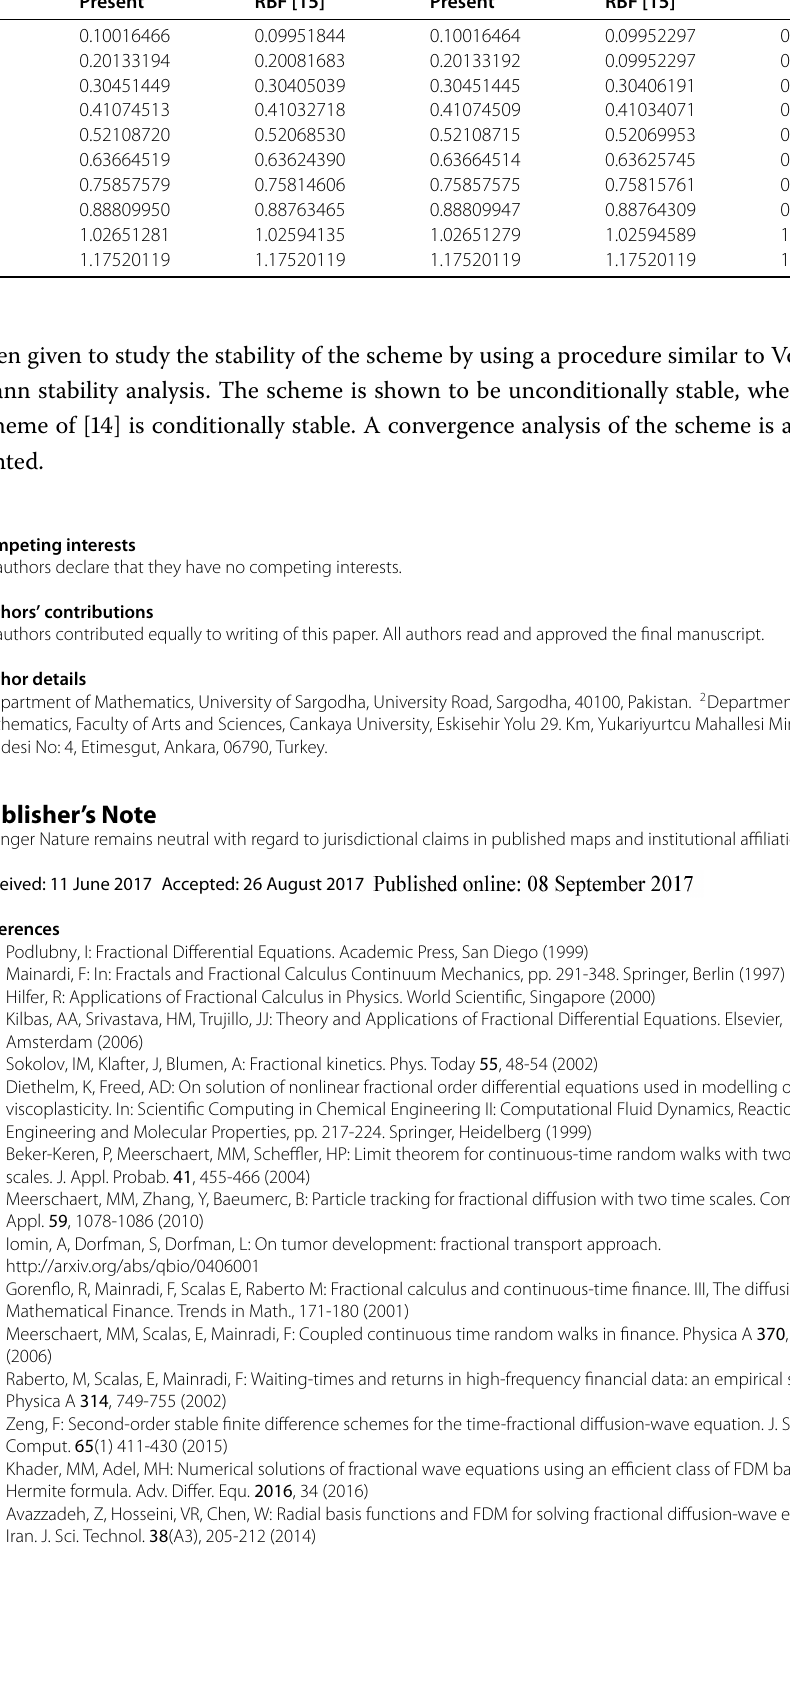
Table 9 The comparison of results for Example 3 when N = 50 and γ = 1.75 at t = 1 x N = 10 N = 50 Exact Present RBF [15] Present RBF [15] 0.1